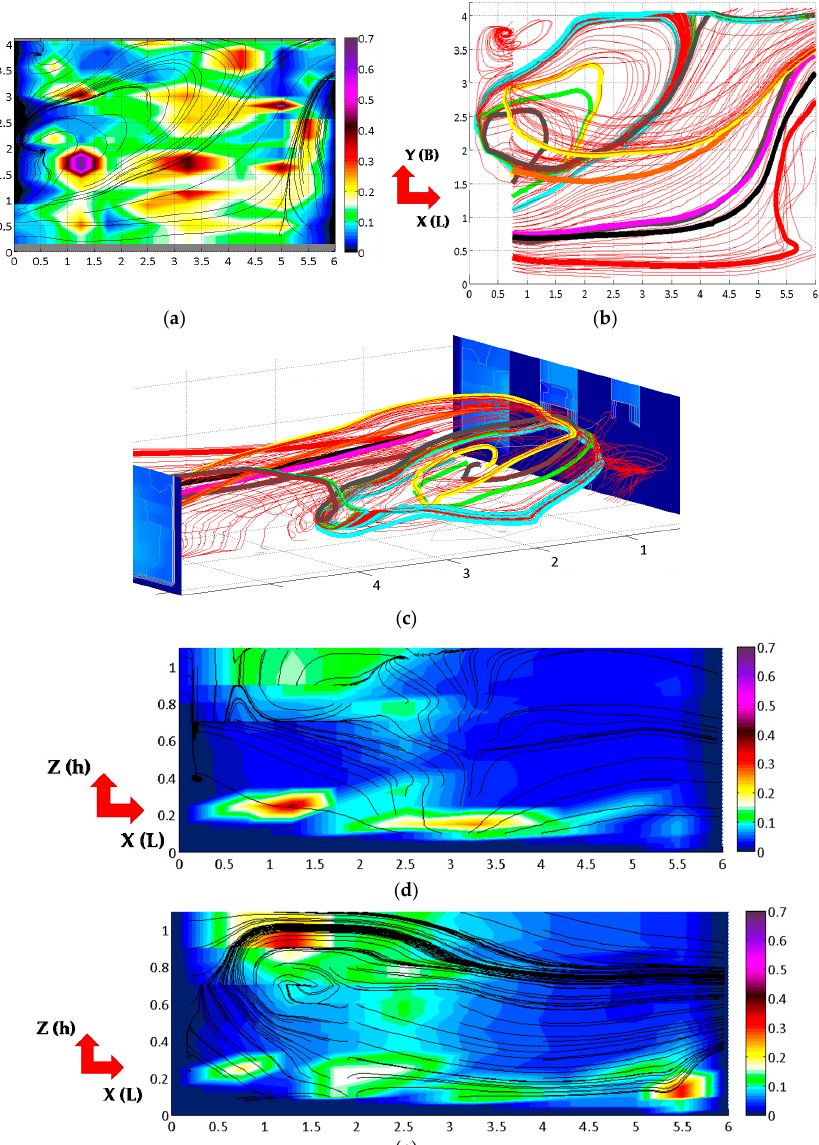
Figure 3. Features of flow structure for model A in the actual scale. ( a ) TKE (m 2 /s 2 ) distribution at P2 with projection of current’s flat lines; ( b ) projection of current lines toward P2-3D structure for model A (relative to Figure ( a )); ( c ) projection of feeding area of flow and whirl structures for model A; ( d ) TKE (m 2 /s 2 ) distribution within the cross-section at a width of 2.8 m (of a small spillway slot); ( e ) TKE (m 2 /s 2 ) distribution within the cross-section at a width of 1.7 m (of a big spillway slot). A dam of water, which is produced by the water of whirl No. 1, can be seen on drawings ( d ) and ( e ); dimensions on the axes